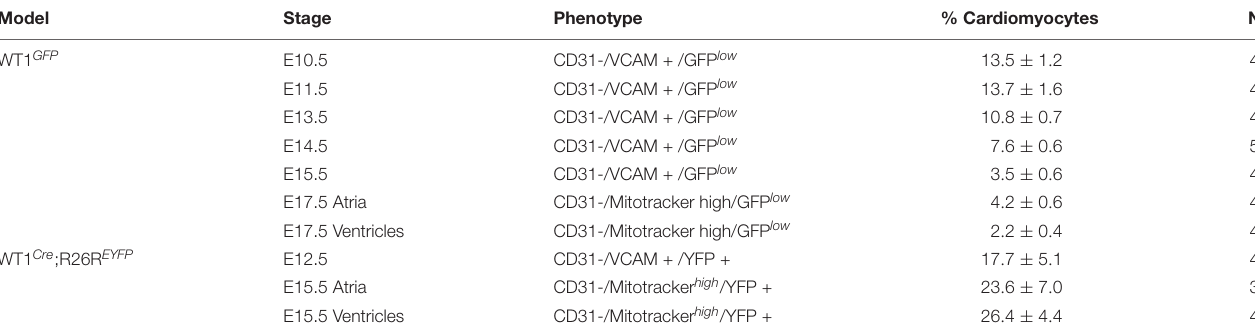
TABLE 1 | Percentage of cardiomyocytes (defined as indicated in the phenotype column) expressing the reporter GFP (knockin line Wt1 GFP / + ) or YFP (lineage tracing line Wt1 Cre ; R26R EYFP ) (mean ± s.e.m.). Model Stage Phenotype %